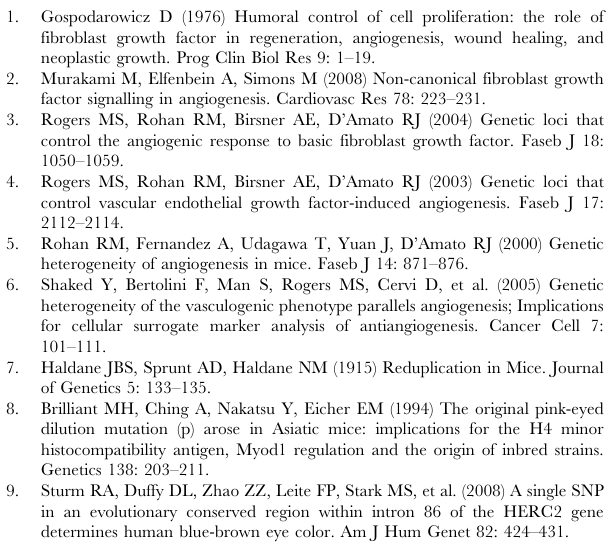
(TIF) Figure S2 Effect of parental gender on vessel area in a 129 6 B6 F1 cross. Pellets contain 10 ng bFGF. The increase in vessel area in the 129B6F1 males is statistically significant (p , 0.05 by ANOVA). (TIF) Figure S3 Simple interval mapping of the initial C57BL/6J 6 SJL/J F2 cross. (TIF) Figure S4 Simple interval mapping of different mea- sures of angiogenic response in the full C57BL/6J 6 SJL/J F2 cross. The use of different measures of angiogenic response as the trait to be mapped was explored. AVA is the (unadjusted) average of vessel areas of the left and right eyes. AVL is the average of the vessel length of the left and right eyes. NORMAVA is the average vessel area divided by (normalized) the vessel area measured in C57BL/6J controls assayed at the same time. (TIF) Figure S5 Effect of SJL alleles on vessel area in B6.SJL Chromosome 5 N6F1 animals. Note the truncated vertical axis. None of these differences are statistically significant (ANOVA). (TIF) Figure S6 Effect of SJL alleles on vessel area in B6.SJL Chromosome 7 N8F1 animals. Note the truncated vertical axis. (TIF) Table S1 Markers showing near-significant and signif- icant association with bFGF-induced corneal neovascu- larization in the initial C57BL/6J 6 SJL/J F2